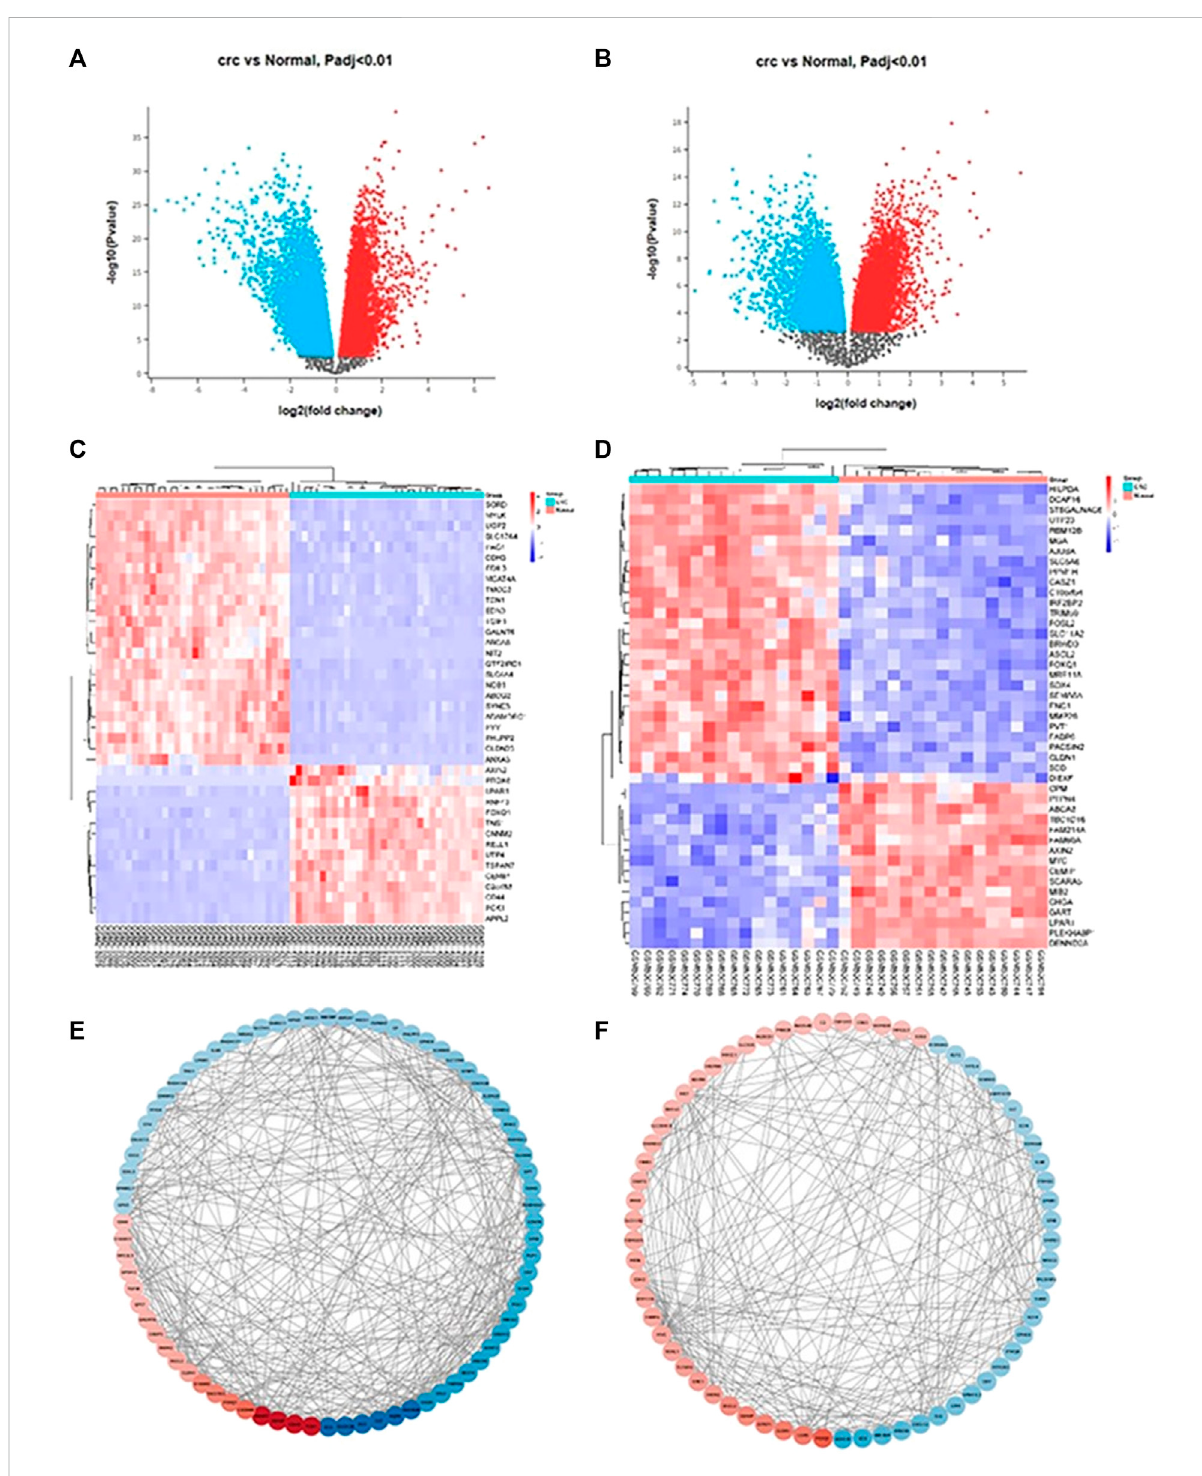
FIGURE 1 (A) GSE32323 volcano plot of differentially upregulated and downregulated genes with signi fi cance p < 0.01, Upregulated genes are shown in red colour, Downregulated genes are shown in blue colour; (B) GSE8671 volcano plot of differentially upregulated and downregulated genes with signi fi cance p < 0.01, Upregulated genes are shown in red colour, Downregulated genes are shown in blue colour; (C) GSE32323 top 100 up and downexpressedgenesheatmap,Upregulated genesareshowninredcolour,Downregulatedgenesareshowninbluecolour. (D) GSE8671top 100 up and down expressed genes heatmap, Upregulated genes are shown in red colour, Downregulated genes are shown in blue colour; (E,F) represents network diagram (arranged according to LogFC value) of top 100 DEGs plotted using STRING and